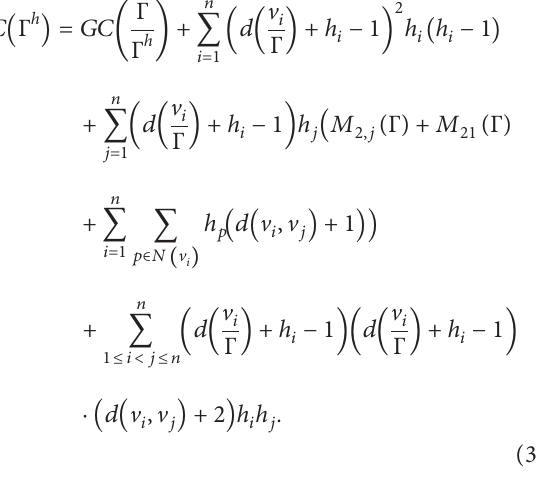
Figure 5: Thorn star.